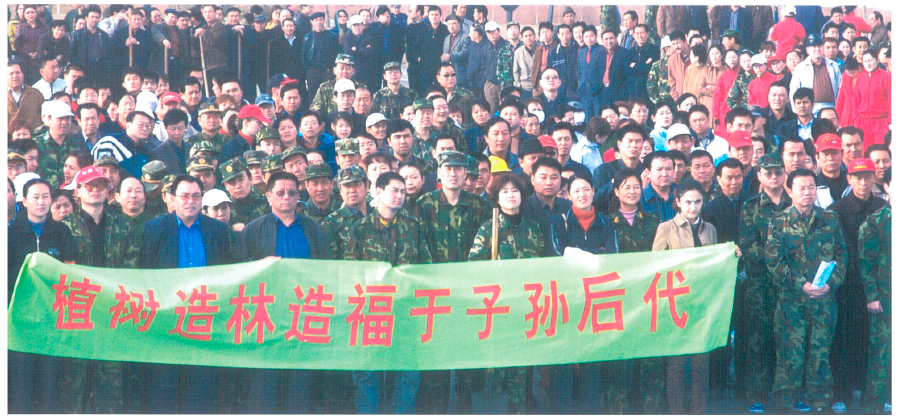
Figure 4. Participants of the afforestation in Kökyar. The banner reads: “Afforestation for the good of future generations”. Adopted from [3].